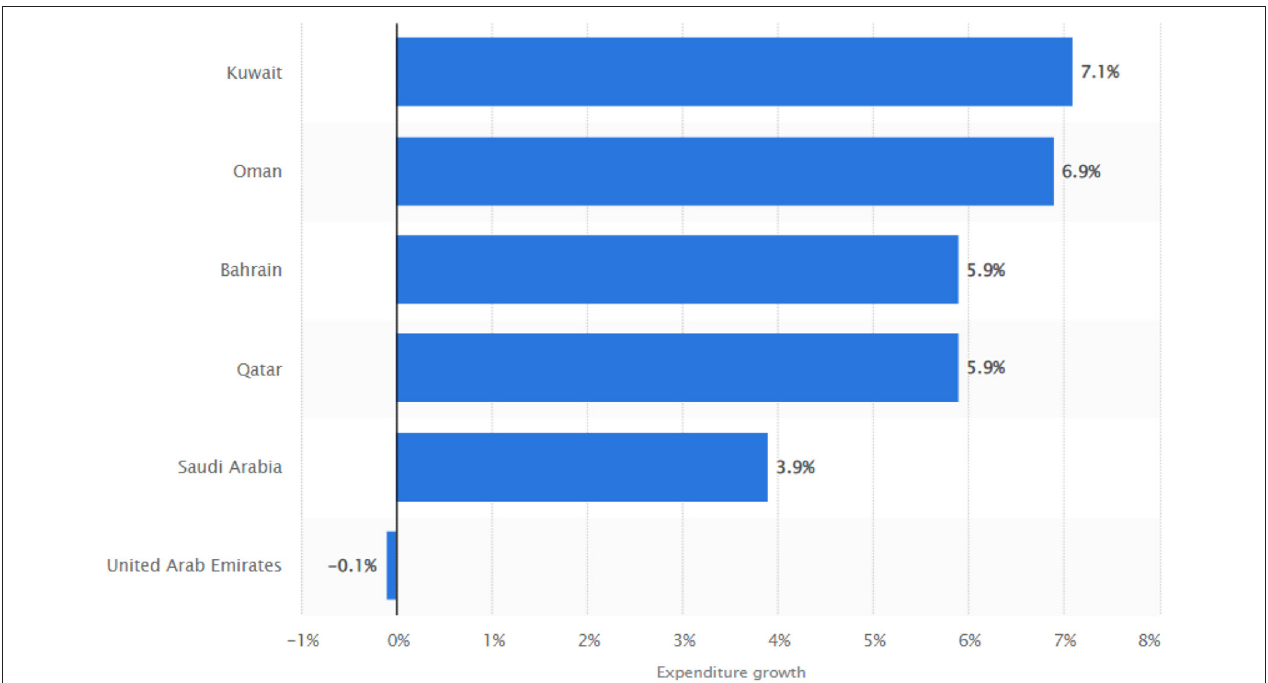
FIGURE 1 | Distribution of healthcare expenditure growths in the Gulf Cooperation Council between 2010 and 2017, by country,